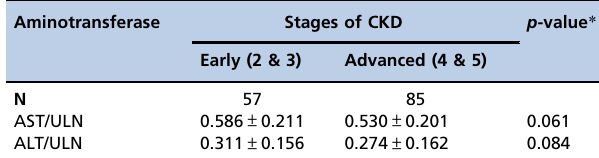
Table 4 - The mean serum aminotransferase levels, divided by the ULN for the early (2 and 3) and advanced (4 and 5) stages of CKD among the 142 patients undergoing conservative